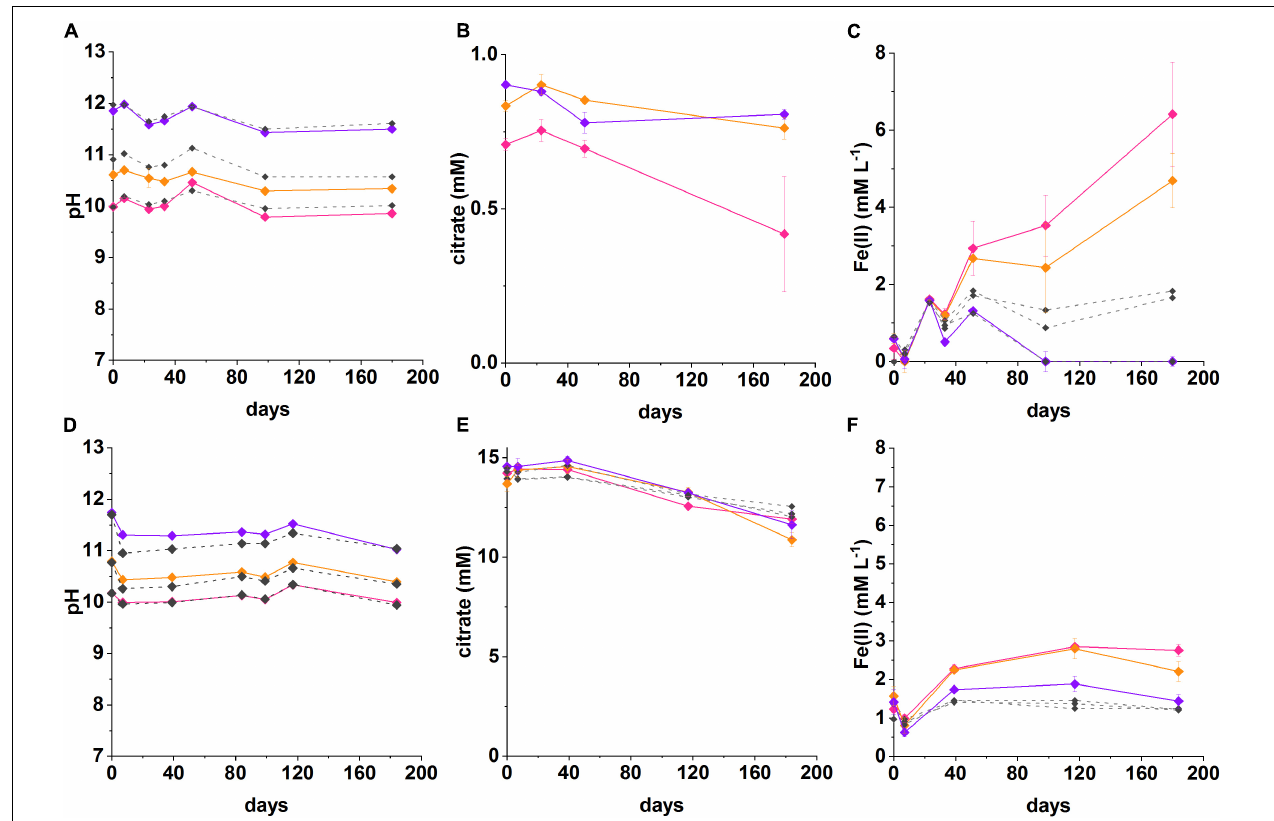
FIGURE 2 | Recorded pH, Fe(II) and citrate measurements from anaerobic, high pH microcosms incubated for up to 200 days at 20 ◦ C in the dark (pH 10—pink, pH 11—orange, pH 12—purple, no-citrate (A–C) and sterile (D–F) control—dashed gray). (A–C) System with 1 mM citrate and 18 mM Fe(III), (D–F) 15 mM citrate and 15 mM Fe(III). The errors are shown and represent 1 SD on triplicate measurements.